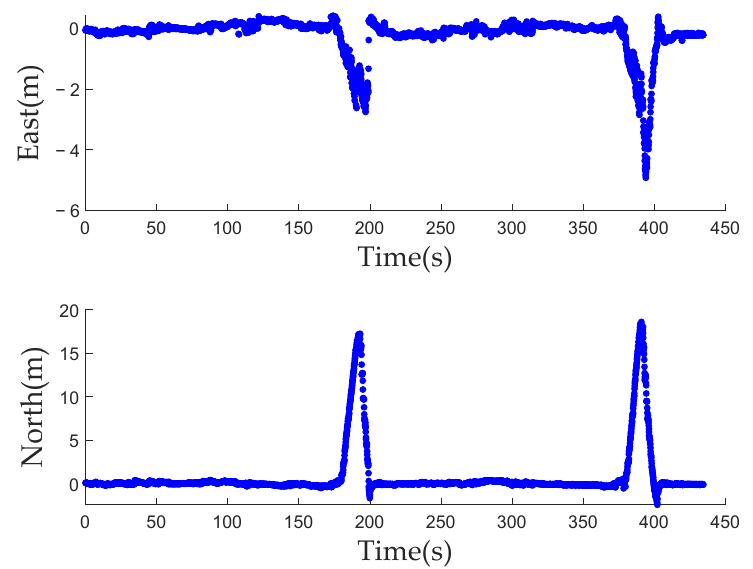
Figure 22. The mean position deviations of the matched targets in the east and north in case two. Similar with Figure 13, Figure 23a shows the fault detection results produced by the magnified in Figure 24a,b. Figure 23b is the result of the proposed LiDAR aided real-time magnified in Figure 24c,d. The fault detection performances of the two algorithms are compared in Table 6. The response time of fault disappearance was 8.94 s and 6.62 s for the residual chi-square test, but they were reduced by 5.465 s on average with the proposed algorithm. Therefore, the low-sensitivity problem of the residual chi-square test for the fault disappearance case is effectively ameliorated. Furthermore, the percentages of false alarm and missed detection were 6.26% and 0.69% for the proposed LiDAR aided real-time fault detection algorithm, which are reductions of 76.49% and 79.03% relative to the residual chi-square test results, respectively.